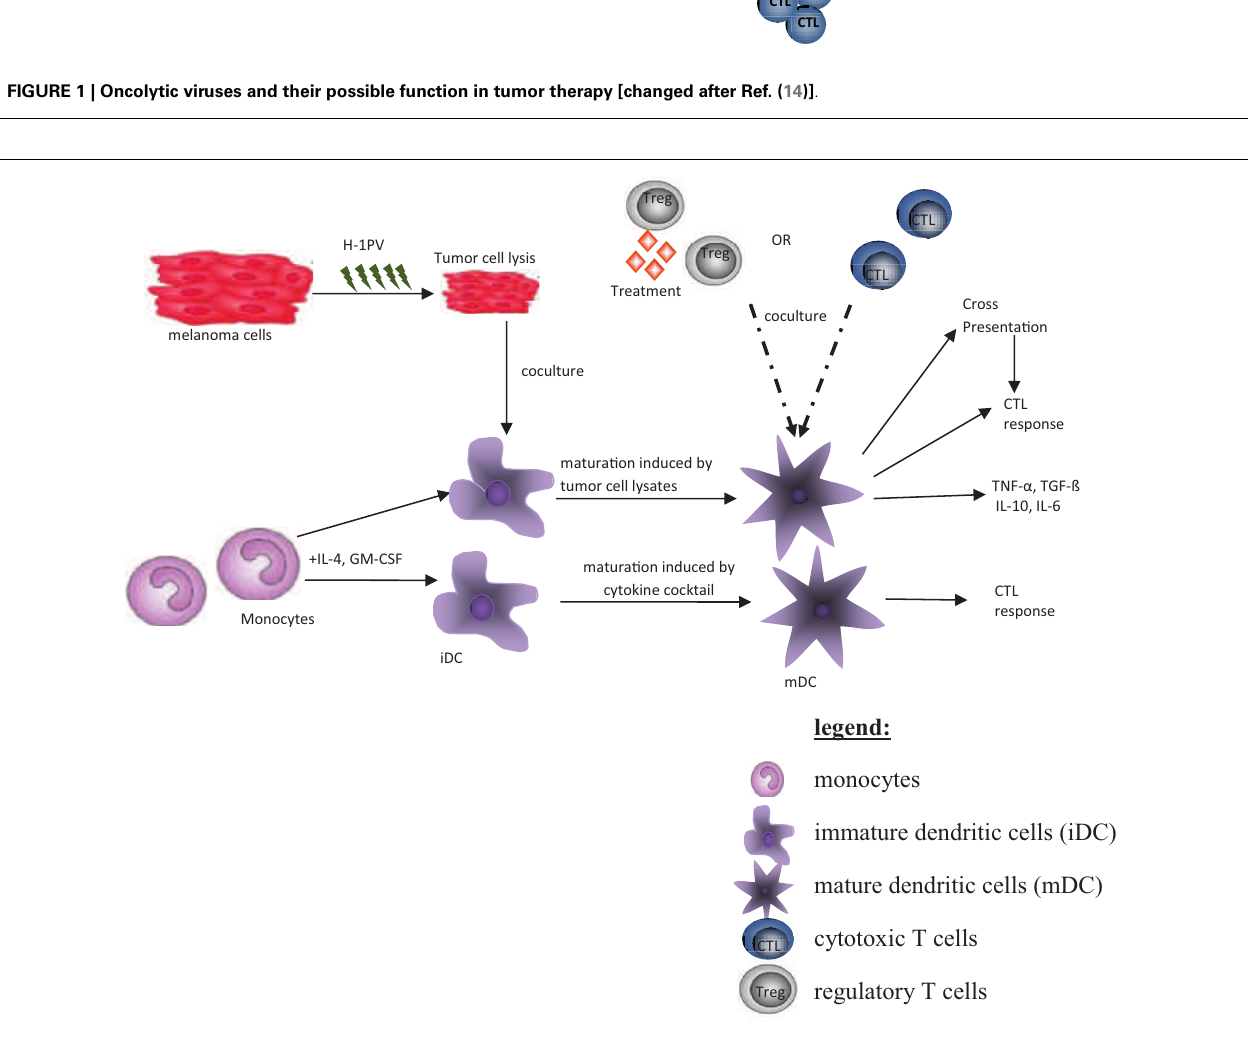
FIGURE 2 |The ex vivo human melanoma model